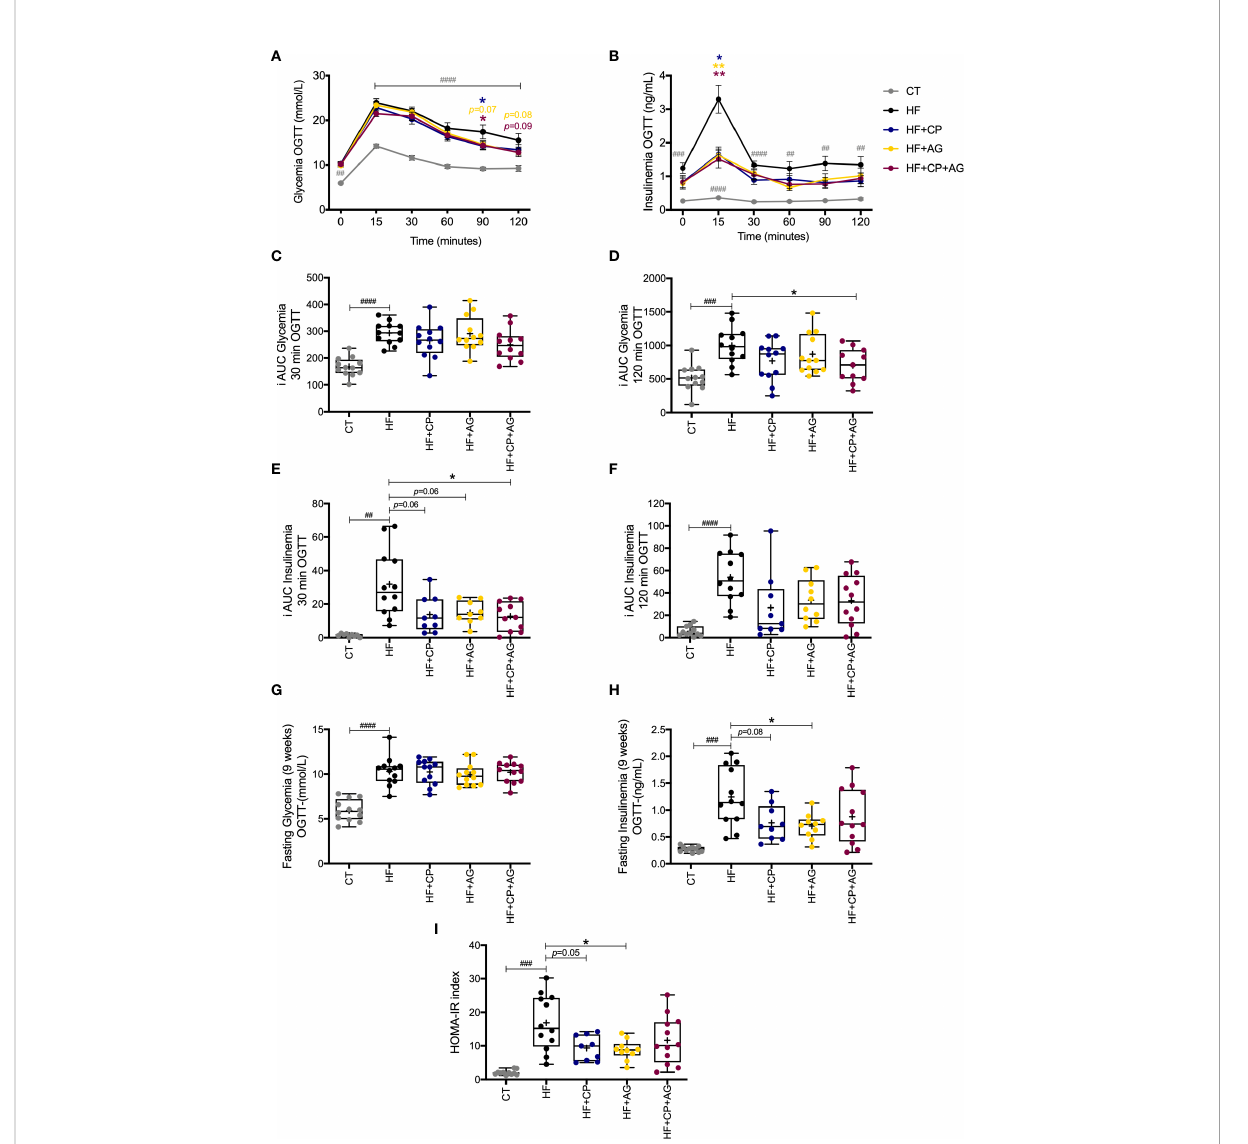
FIGURE 2 Effects of cranberry polyphenols (CP) and agavins (AG) in glucose in HFHS-diet induced obese mice. Mice were fed either a chow diet (CT) or high- fat high-sugar diet (HF); mice on an HF diet were supplemented with CP (HF+CP), AG (HF+AG), or the combination of both CP+AG (HF+CP+AG) for 9 weeks. Blood samples were collected at different time points during OGTT for glycemia and insulinemia measurements (A – H) . (A) Glycemia during OGTT (mmol/L). (B) Insulinemia during OGTT (ng/mL). (C) Mean plasma incremental area under the curve (iAUC) glucose 0 – 30 min OGTT. (D) Mean plasma (iAUC) glucose 0 – 120 min OGTT. (E) Mean plasma iAUC insulinemia 0 – 30 min OGTT. (F) Mean plasma iAUC insulinemia 0 – 120 min OGTT. (G) Fasting plasma glycemia levels during OGTT (mmol/L). (H) Fasting plasma insulinemia levels during OGTT (ng/mL). (I) Homeostasis model assessment of insulin resistance index (HOMA-IR). Two-way repeated-measure ANOVA (RM two-way ANOVA) with Dunnett ’ s multiple- comparison test ( post-hoc test) was employed to calculate the signi fi cance between groups at different time points. One-way ANOVA with a Dunnett ’ s multiple-comparison test ( post-hoc test) was employed to calculate the signi fi cance of the differences between groups. Values are expressed as the mean ± SEM. Boxplots represent the distribution of data with the mean represented by the mark “ + ” within the boxes, the median represented by the dark horizontal line and interquartile range by the box. * p < 0.05; ** p <0.01 as compared to the HFHS-control group. ## p < 0.01; ### p < 0.001; #### p < 0.0001 chow-control group versus HFHS-control